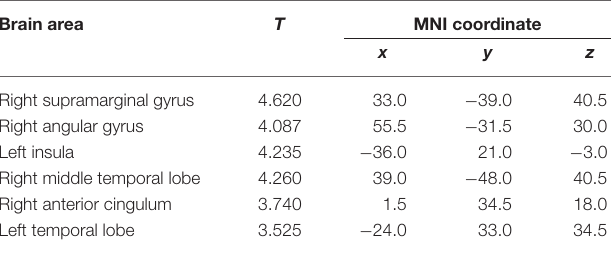
Differences in brain regions were obtained by subtracting the results for the OPVHs patients from those of the CNs using the two independent samples t-test